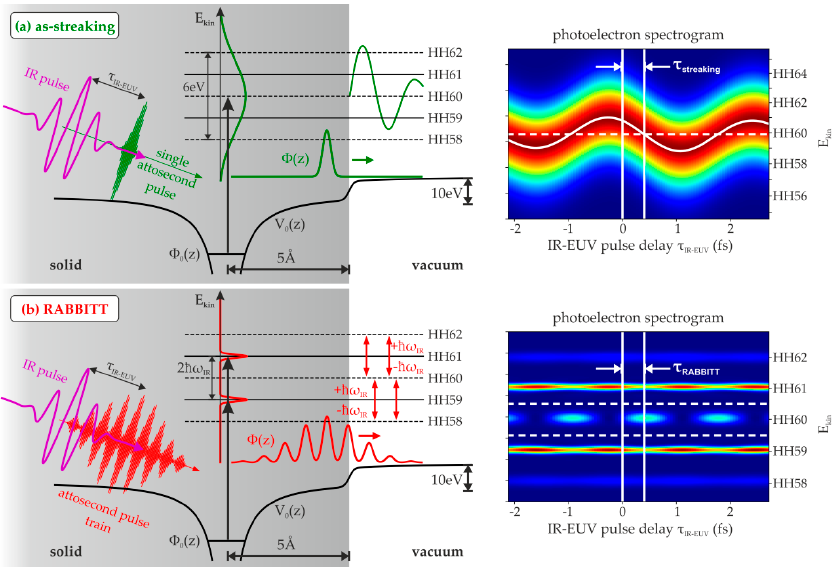
Figure 1. Principle of ( a ) as-streaking and ( b ) reconstruction of attosecond beating by interference of two-photon transitions (RABBITT) at solid surfaces: Initial state Φ 0 ( z ) is excited into the continuum by a single-attosecond extreme-ultraviolet (EUV) pulse (green) or by an attosecond pulse train (red),